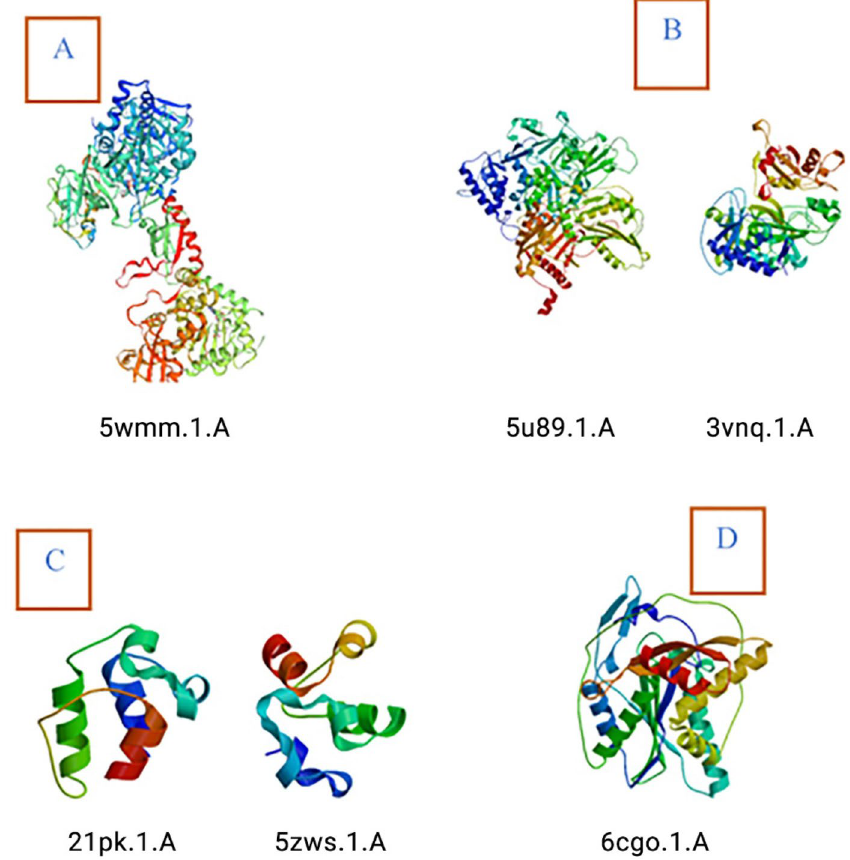
Figure 3. SWISS-MODEL; 3-D NRPS sequence and NRPS domain fragments using templates: ( A ) 5wmm.1.A (PDB code for NRPS). ( B ) 5u89.1.A (PDB code for amino acid adenylation domain), 3vnq.1.A (PDB code for NRPS adenylation protein CytC1). ( C ) 2lpk.1.A and 5zws.1.A (PDB Specialized acyl carrier protein and Acyl carrier protein for PCP domain]. ( D ) 6cgo.1.A (PDB code C